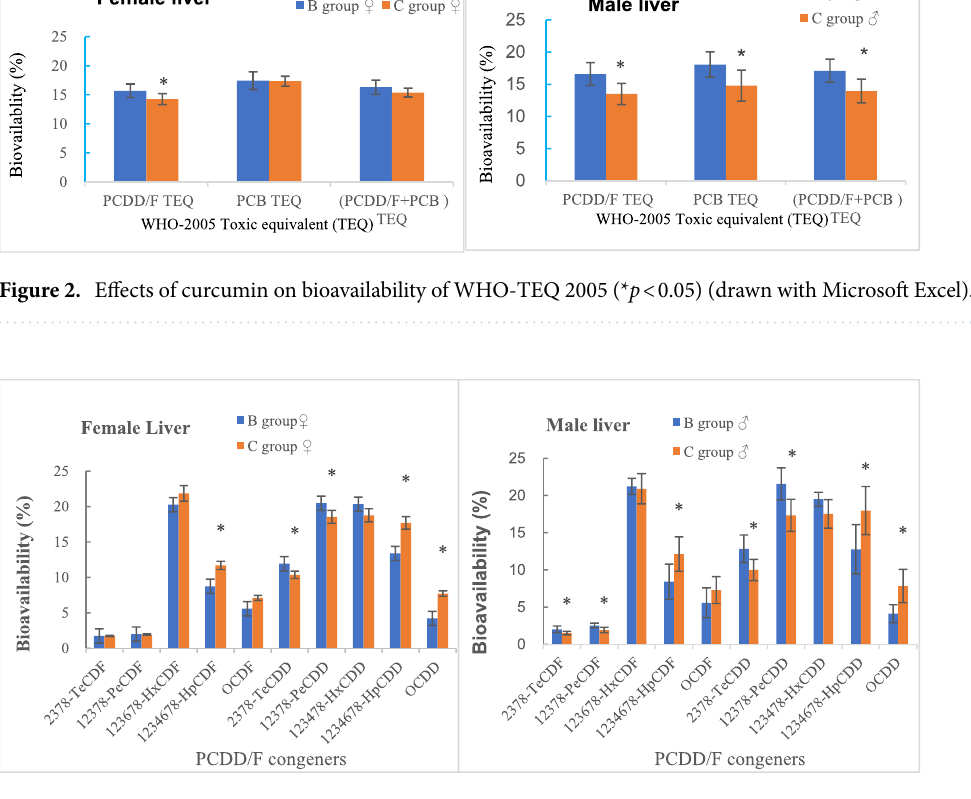
Figure 3. Effects of curcumin on bioavailability of PCDDF congeners (* p < 0.05) (drawn with Microsoft